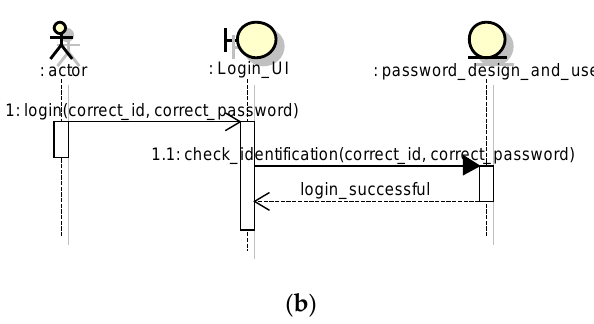
Figure 3. Login behavior (Password Design and Use pattern). ( a ) Failure case; ( b ) Success case.